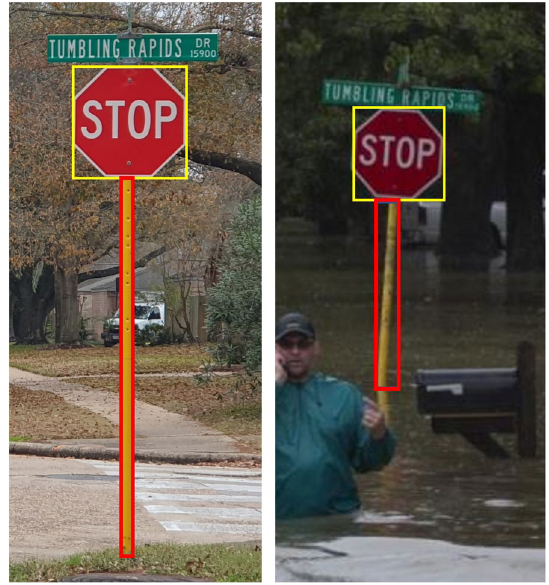
Fig. 8 Sample annotated a pre-flood photo, and b post-flood photo (base photo in (b) is courtesy of Erich Schlegel/Getty Images)